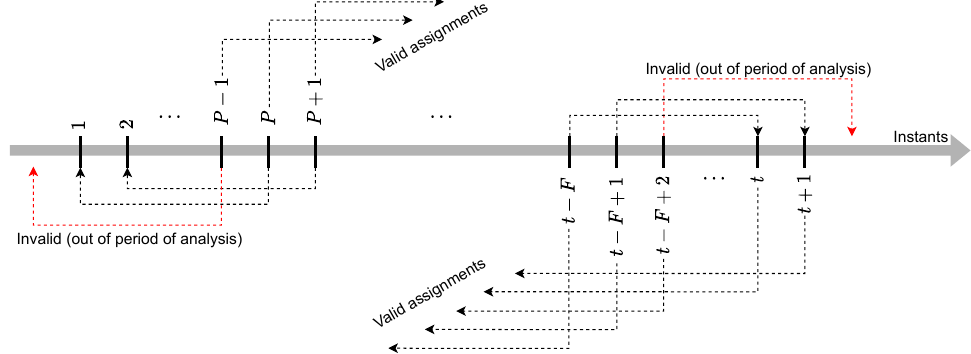
Figure 3. Representation of instants and past and future